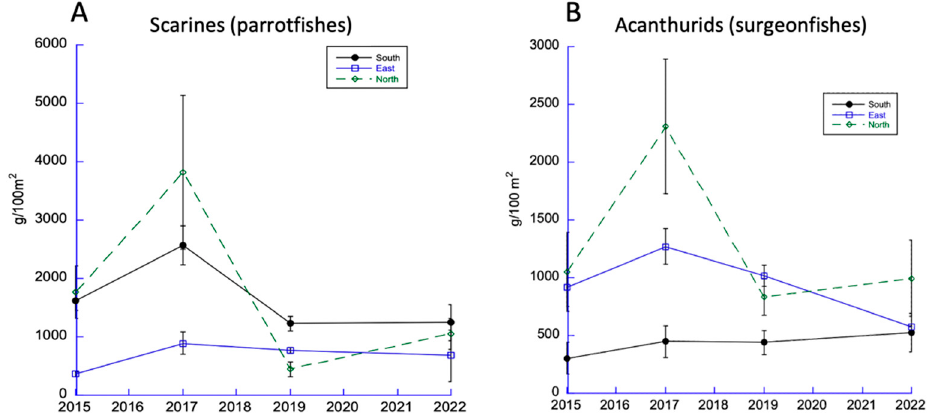
Figure 4. Trends in dominant DR herbivorous fishes (parrotfishes ( A ) and surgeonfishes ( B )). Macroalgae have dominated reefs in the East Sector since monitoring began (Figure